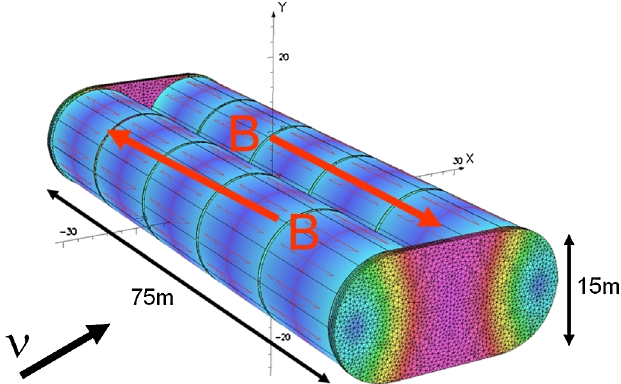
FIG. 17. (Color) Magnetic cavern concept for a 22.5 Kton fidu- cial mass low-energy NF detector, constructed from ten sole- noids. Each solenoid is constructed by winding the STL (see text) into